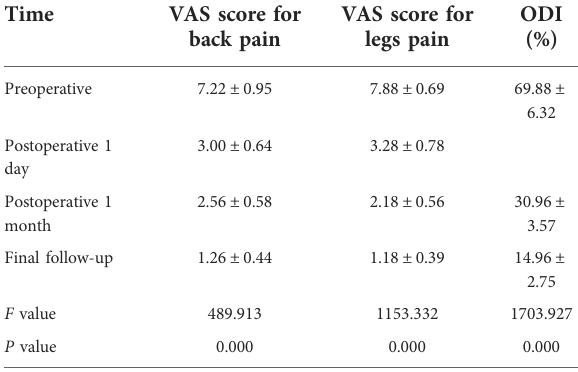
TABLE 2 Clinical outcomes in dif fi dent times.